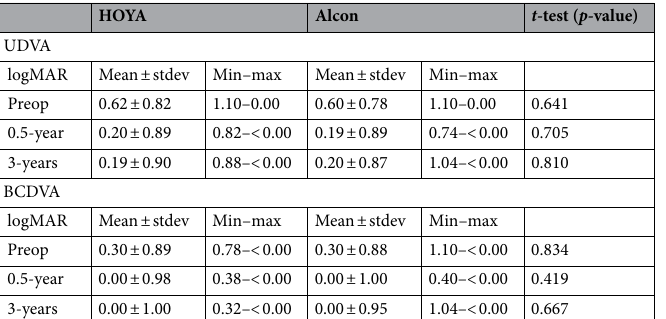
HOYA Alcon t -test ( p